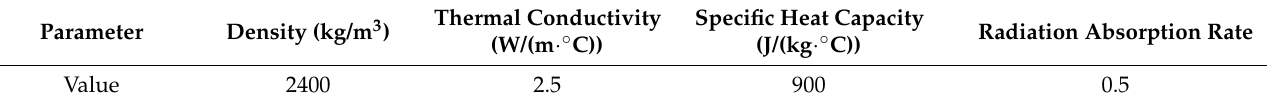
Figure 12. Section measuring point arrangement and size diagram. Table 1. Thermal parameters of materials.